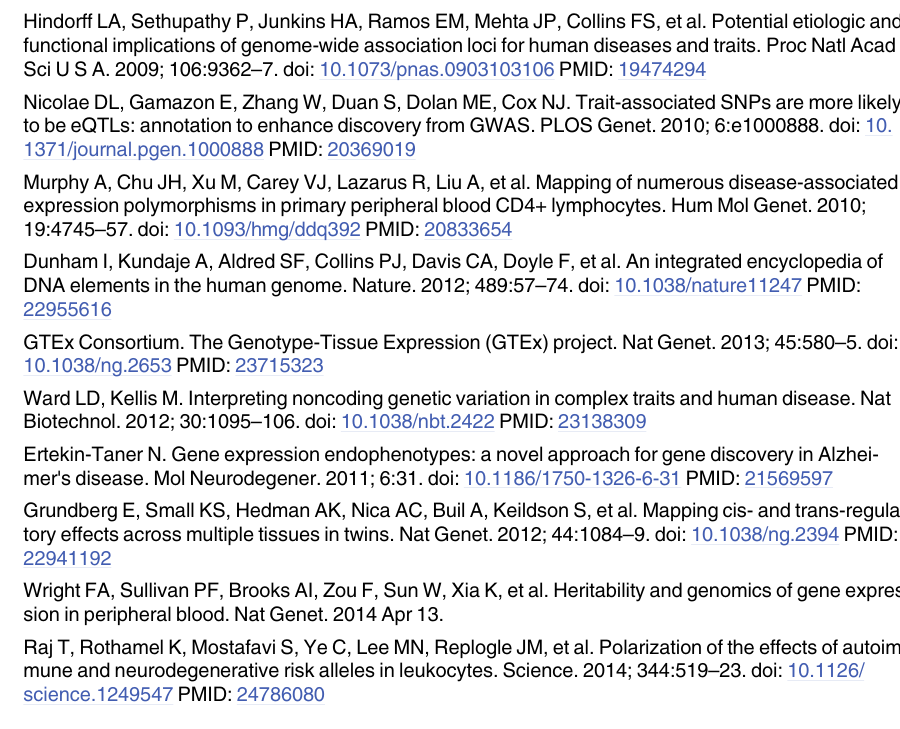
and the last count in the top right-hand corner is in the count in the range χ 2 (cid:1) 87.9. The hori- zontal lines represent different thresholds of false discovery rates (0.1%, 0.5%, 1%, and 5%). (TIF) S2 Fig. Forest plot of component effects of two smaller GWAS predictive models based on training set of SNPs. Odds ratios (black squares) for model features predicting the member- ship of a SNP in the NHGRI GWAS Catalog are shown here with standard errors (gray lines). The complete multivariate model is shown in Fig 4. There are three classes of SNP annotation represented in each of the two models, each with multiple levels: distance from the transcript boundaries of its target gene, its MAF, and its gene structural classification ( “ structure [M1] ” , top panel) or predicted chromatin state in GM12878 LCLs [12] ( “ chromstate [M2] ” , bottom panel). The base levels for each annotation are “ 0 kb (within gene) ” [Distance from Gene], “ > 10% ” [MAF], and “ none ” [Structural Annotation] or “ Heterochromatin (13) ”